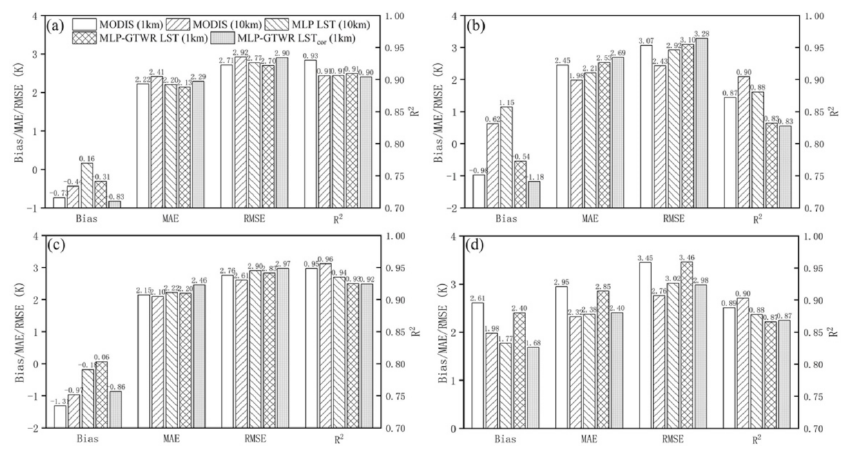
Figure 5. Comparisons of the 1-km MODIS LST, aggregated 10-km MODIS LST, 10-km MLP LST,